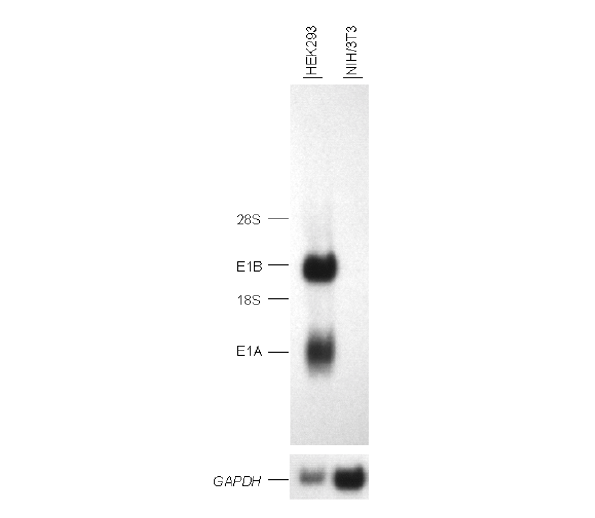
Figure 4 Expression of E1A and E1B transactivators in human embryo kidney cell line 293. A Northern blot analysis using equal amounts (30 µ g) of total cellular RNA from